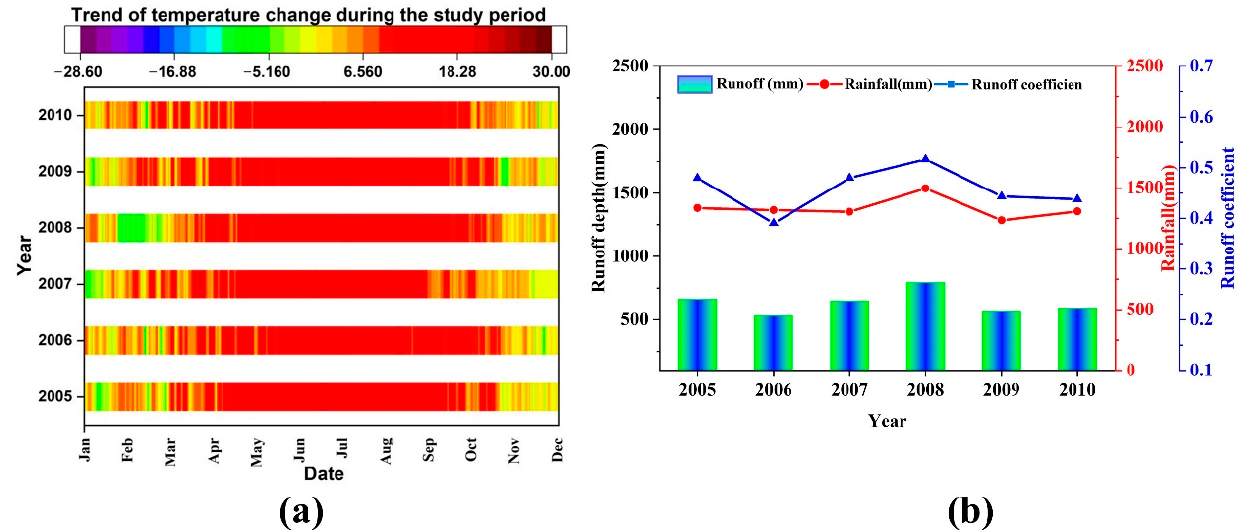
Figure 5. Hydrology and climate change during the study period: ( a ) temperature change; ( b ) annual rainfall–runoff change.